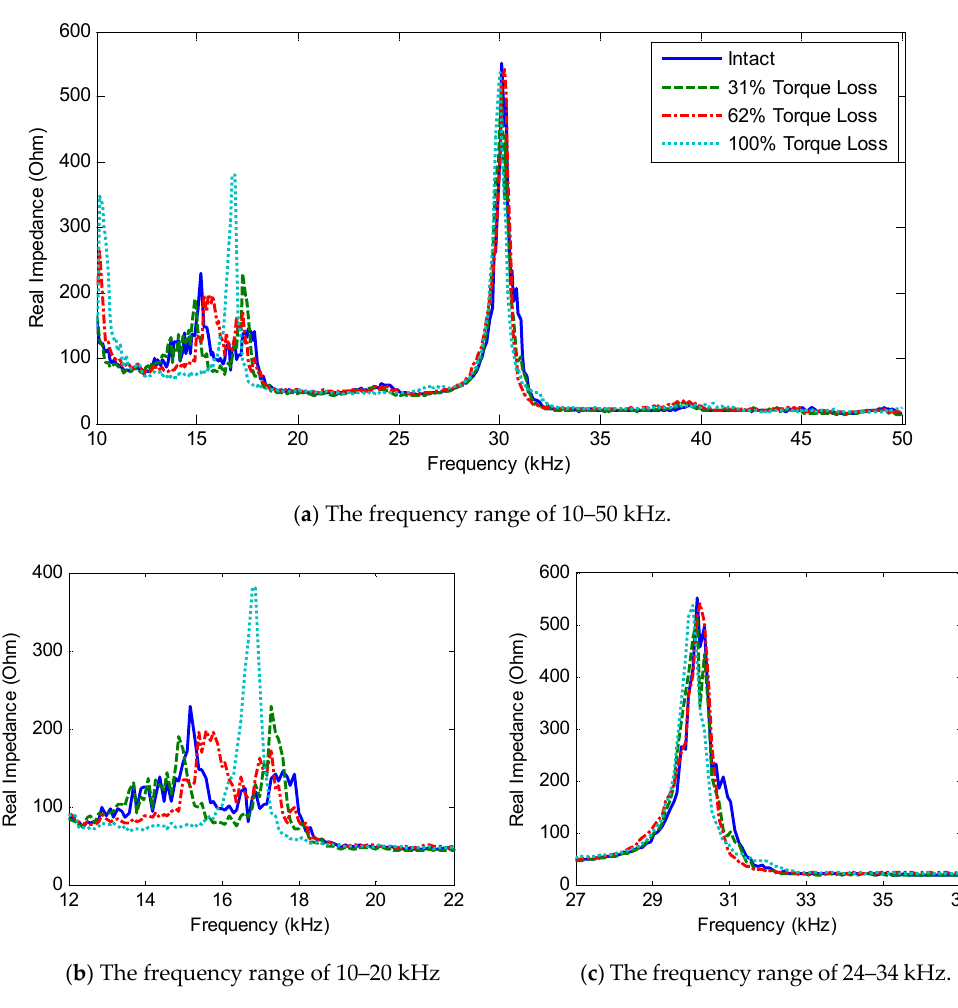
Figure 13. Experimental impedance signatures under bolt-loosening cases of Bolt 3.